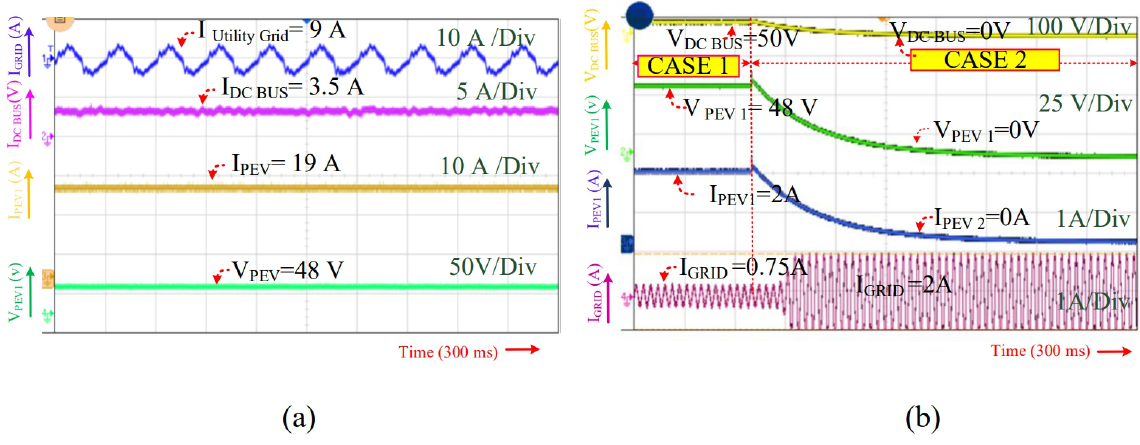
Fig. 10. Experimental Result: (a).Utility grid to PEV mode, (b). Different Utility grid